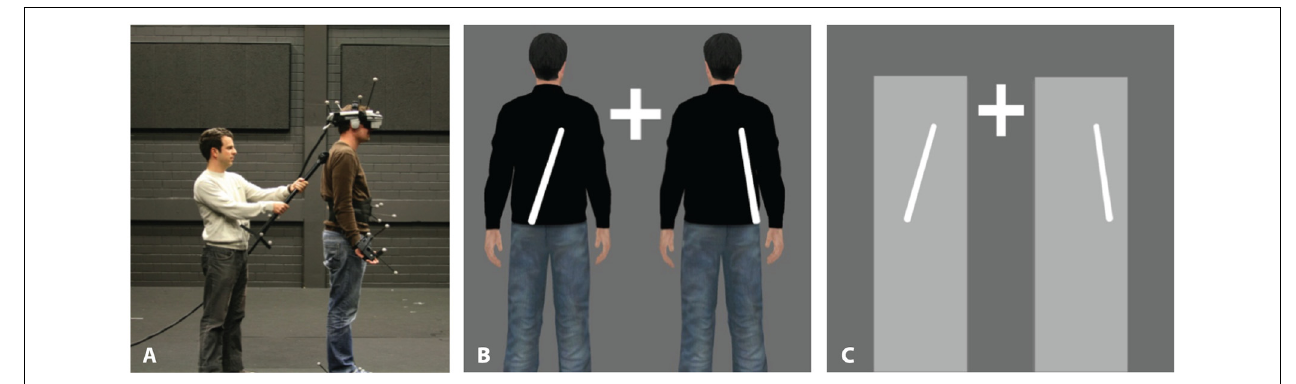
FIGURE 2 | Setup and visual stimulus Study 2. (A) . Experimenter stroking a participant who is wearing an HMD, and tracking objects for feet, hands, and torso.The subject of the photograph has given written informed consent